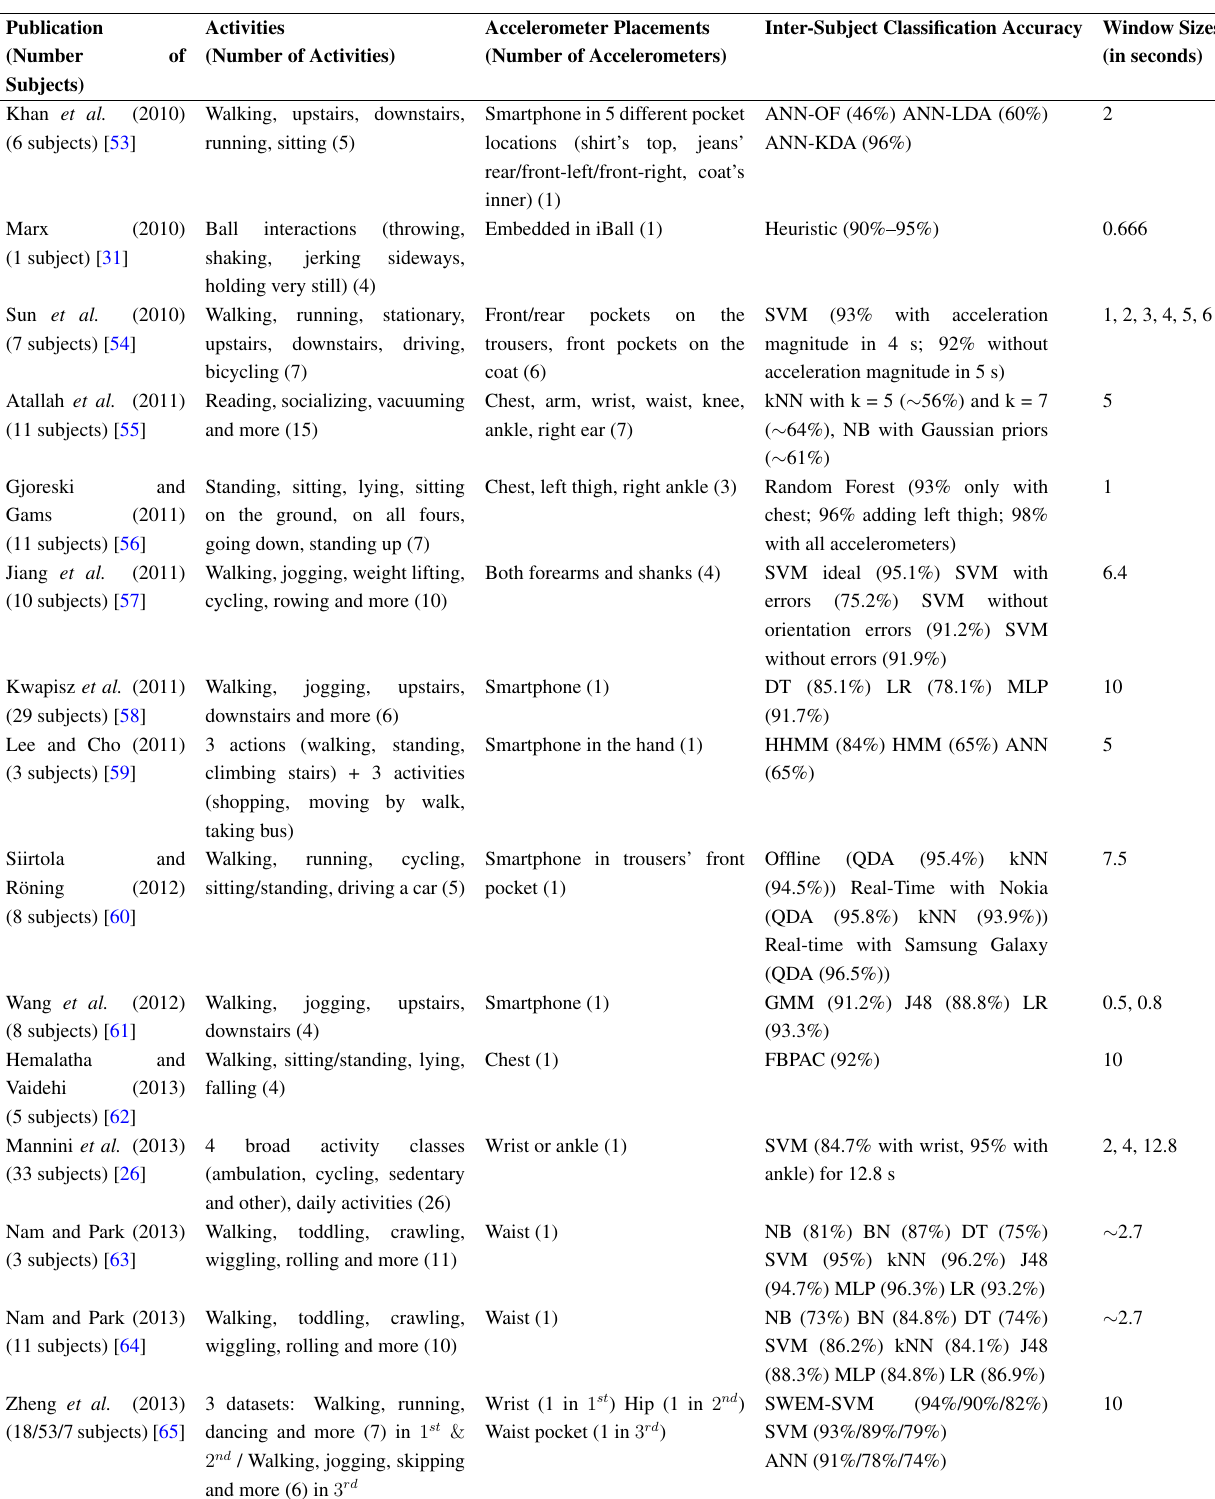
Table 3. Studies that use the sliding window approach (Part